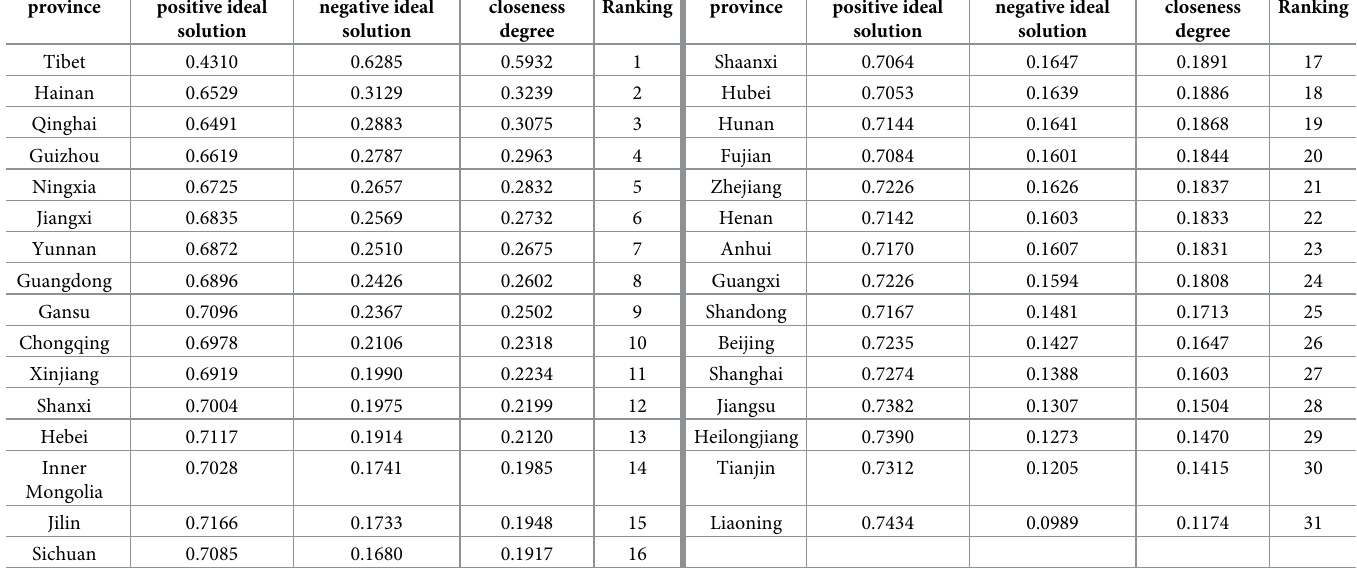
Table 4. Ranking of provincial innovation